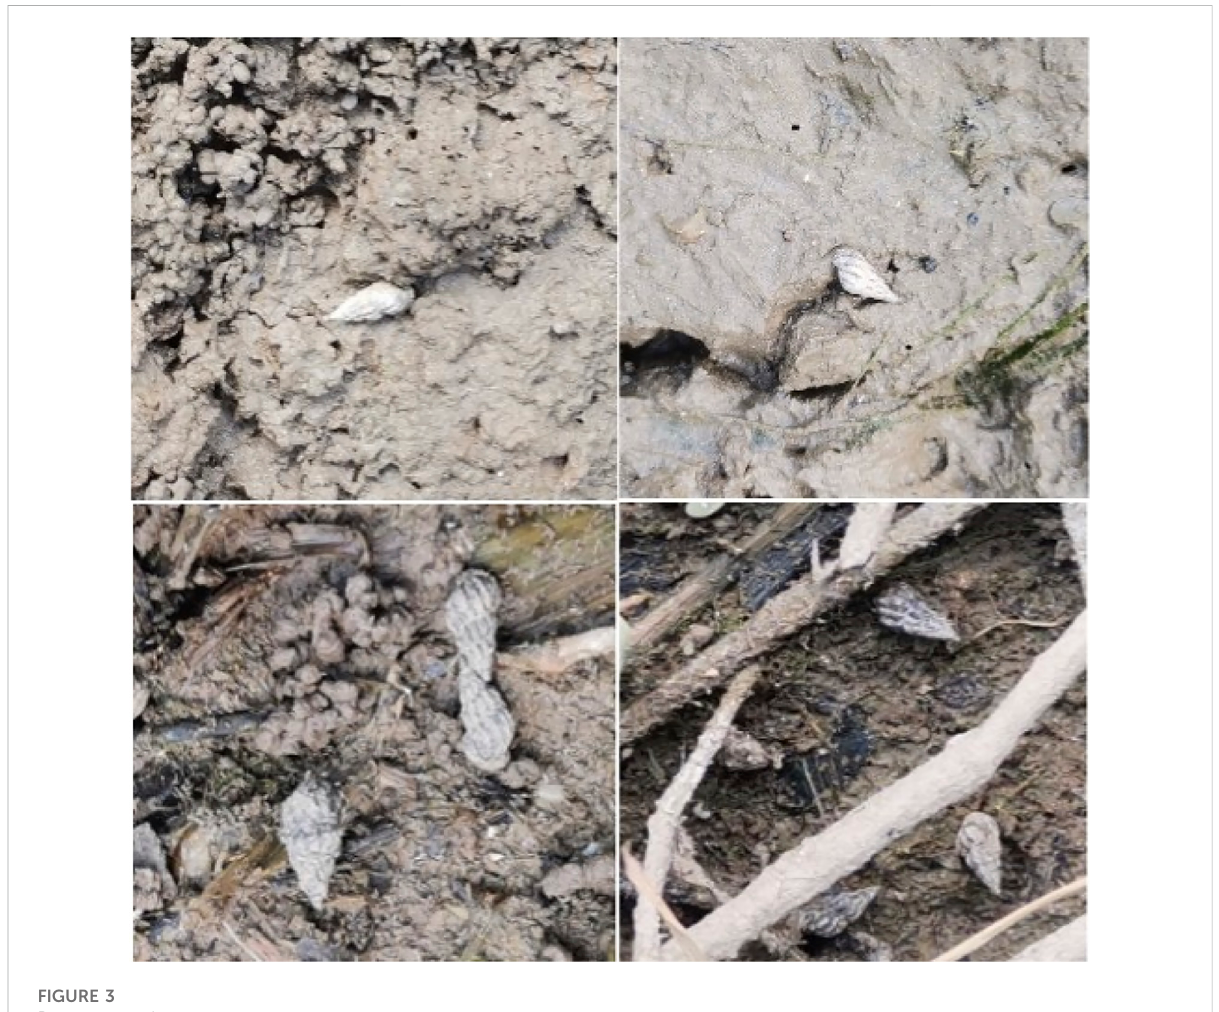
FIGURE 3 Data set